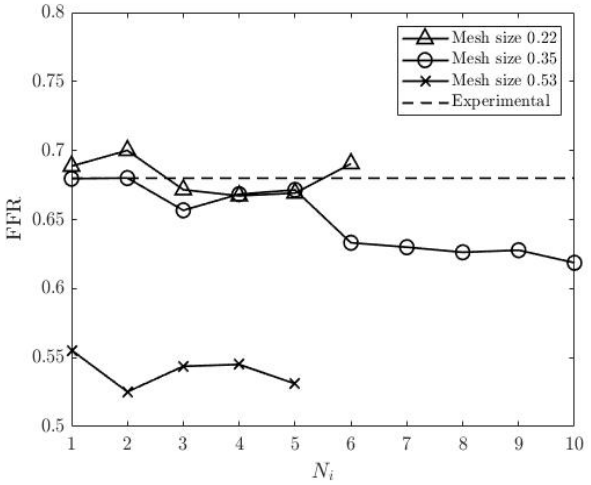
Figure 13. FFR values in each round of iteration for CHN13 [19].